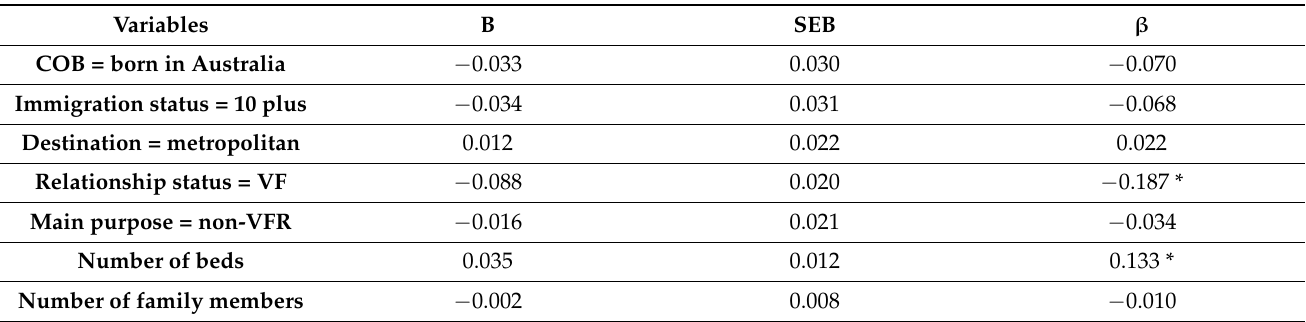
Table 8. Regression analysis summary of the host’s variables predicting the number of VFRs staying with hosts.